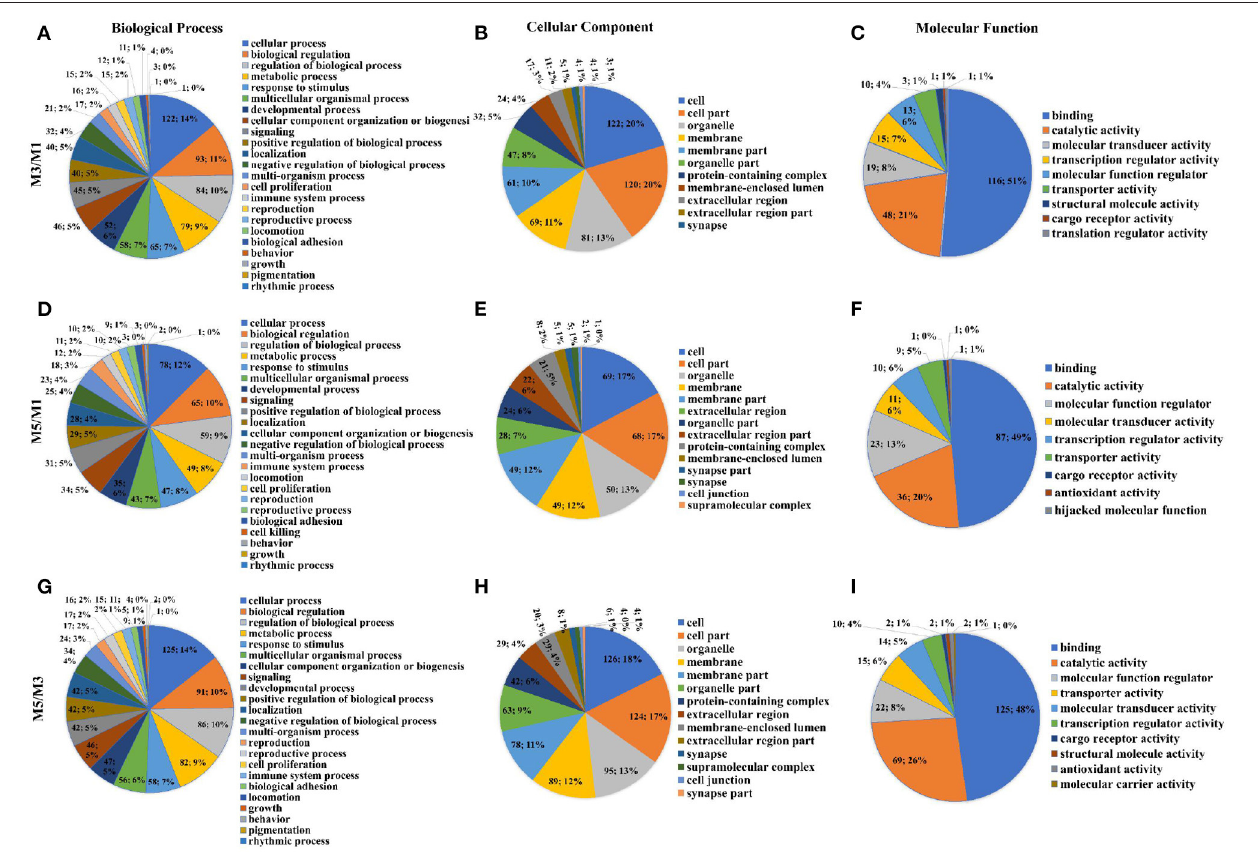
FIGURE 4 | Proportions of different gene ontology (GO) terms (level two) in the ileum mucosa of pigs with different feeding regimens. Proportions of different GO biological process terms (A) , GO cellular component terms (B) , GO molecular function terms (C) between M3 and M1 groups. Proportions of different GO biological process terms (D) , GO cellular component terms (E) , GO molecular function terms (F) between M5 and M1 groups. Proportions of different GO biological process terms (G) , GO cellular component terms (H) , GO molecular function terms (I) between M5 and M3 groups. M1, one meal per day; M3, three meals per day; M5, five meals per